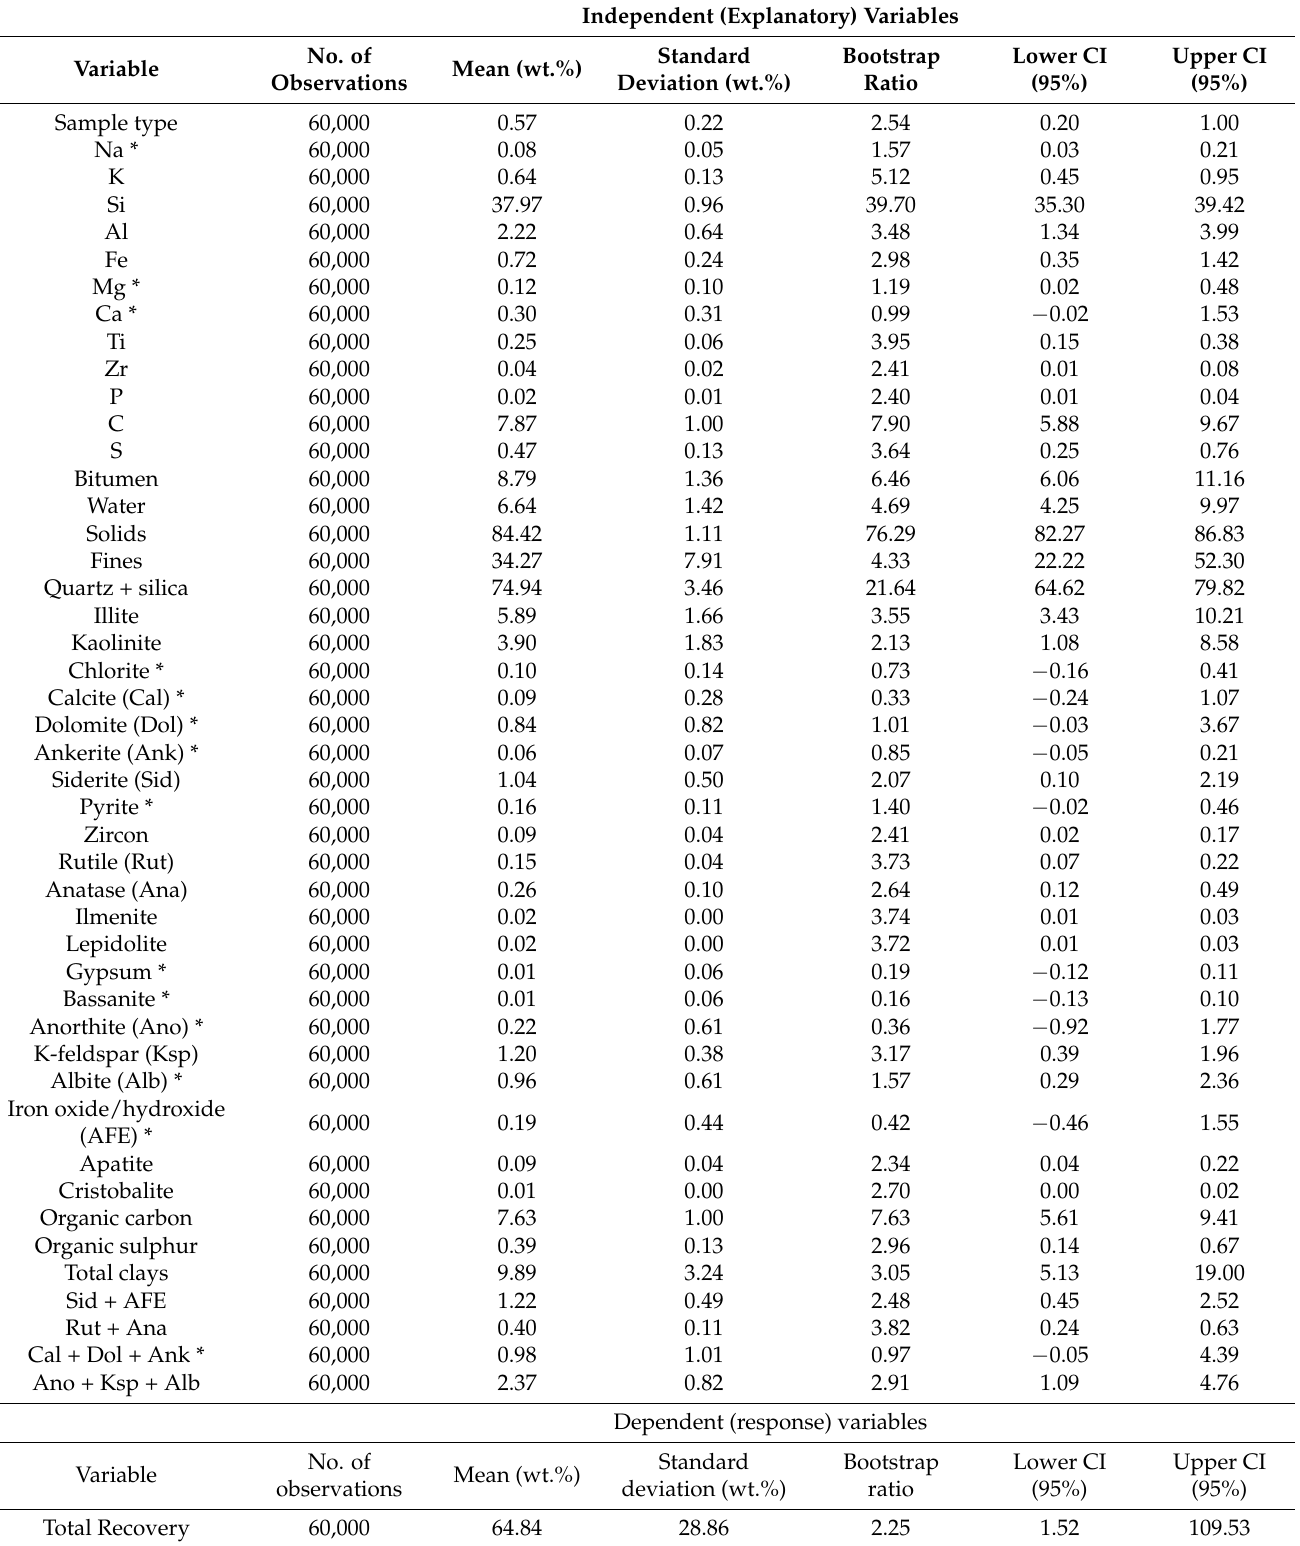
Table 4. Summary of statistics from 10,000 replications of the bootstrap cross-validation